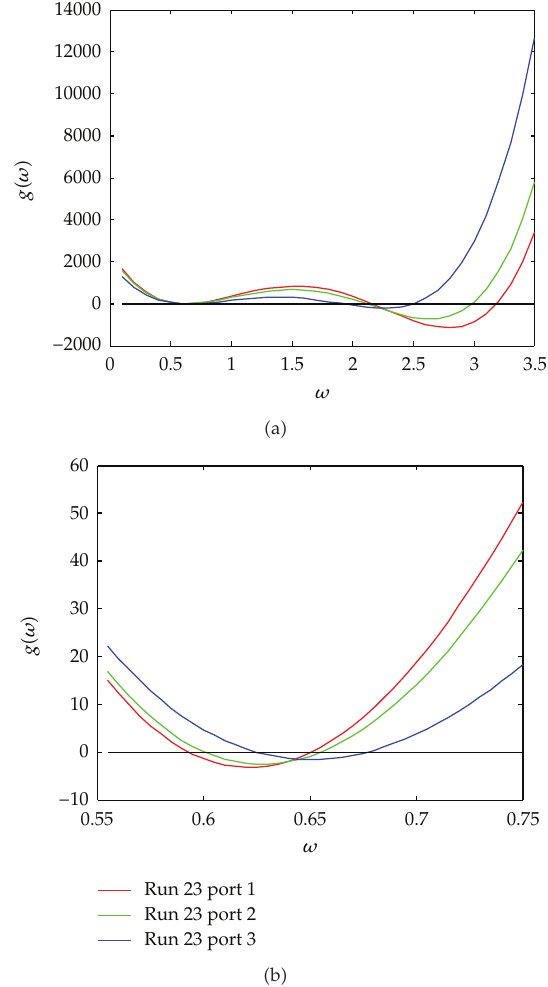
Figure 7: g (cid:2) w (cid:3) for Run 23 over (cid:2) a (cid:3) a wide range of ω from 0 to 3.5 and (cid:2) b (cid:3) a narrow range of ω